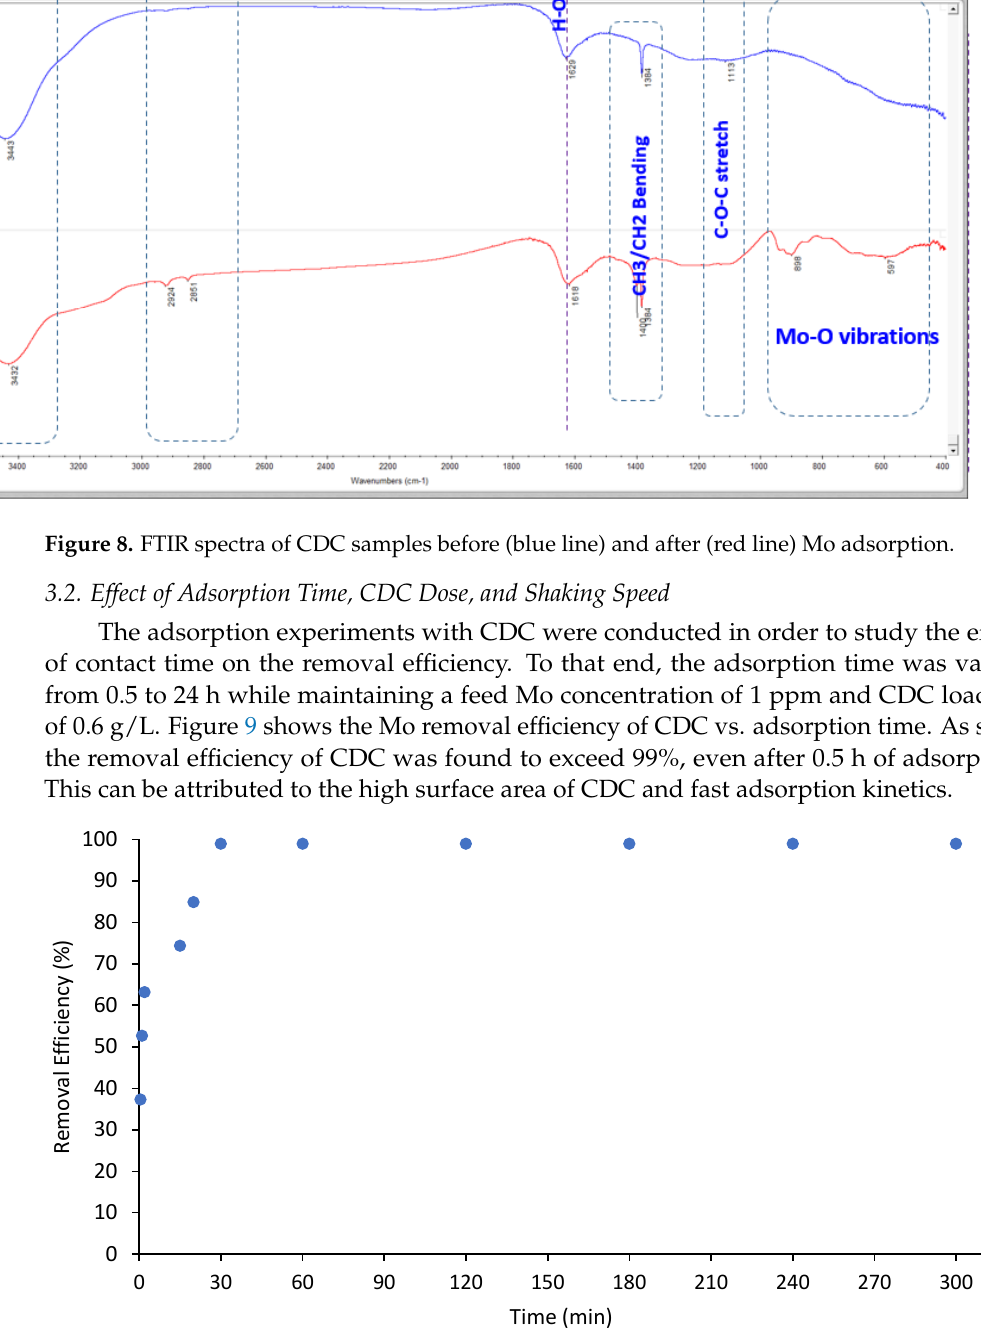
Figure 9. Removal efficiency of CDC vs. adsorption time: Mo concentration: 1 ppm, CDC loading: 0.6 g/L, pH: 5.2, agitation speed: 150 RPM.